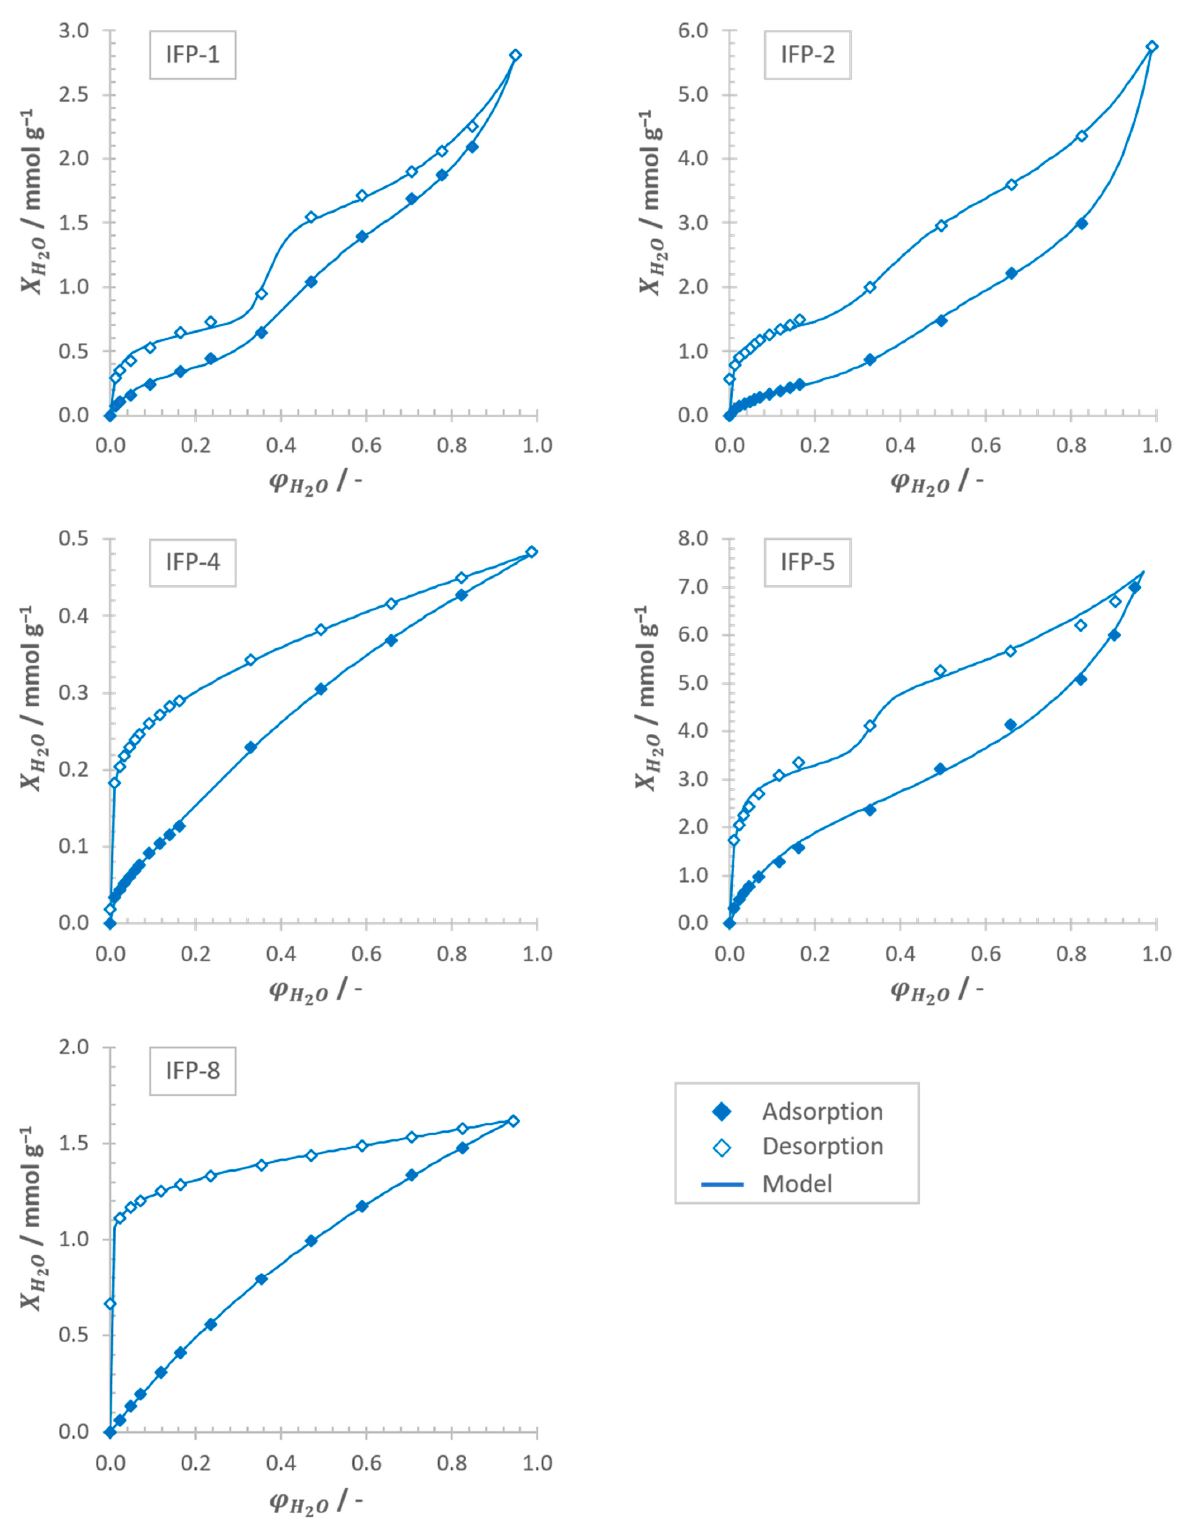
Figure 7. Adsorption (full diamonds ◆ ) and desorption (empty diamonds ◇ ) equilibria of water vapor on all IFP samples at T = 303.15 K approximated by the model equation (straight line — ).